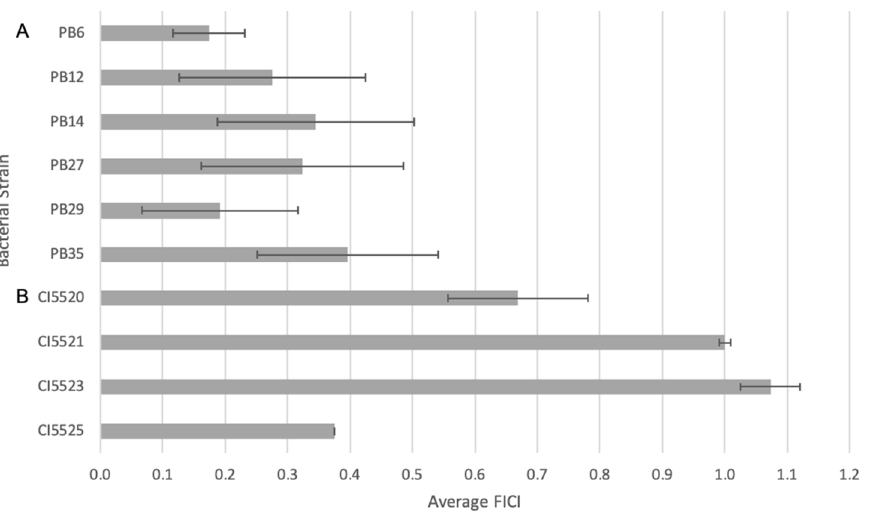
Figure 1. Fractional inhibitory concentration index (FICI) of PMB and LL-37 against ( A ) E. coli and ( B ) P. aeruginosa CIs, where FICI ≤ 0.5 is synergistic, 0.5 < FICI ≤ 1.0 is additive, 1.0 < FICI ≤ 4.0 is indifferent, and FICI > 4.0 is antagonistic. The synergistic responses of LL-37 and PMB against clinical, drug-resistant isolates of E. coli and P. aeruginosa were evaluated using checkerboard assays. The microtiter plates were incubated at 37 °C under static conditions for 18–22 h before 100 μ L of 0.2 mM resazurin was added to all wells. After an additional incubation of 2 h, the levels of reduced resazurin were quantified at 560 nm. Control wells included MH media and bacteria in the absence of antimicrobial agents as sterility and growth controls, respectively. The mean FICI and standard deviations for 10 different clinical, drug-resistant isolates were calculated from at least three independent experiments.